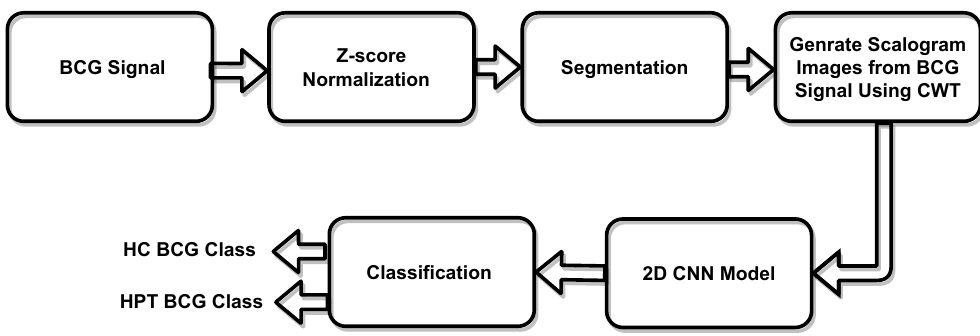
Figure 2. Work flow of the proposed